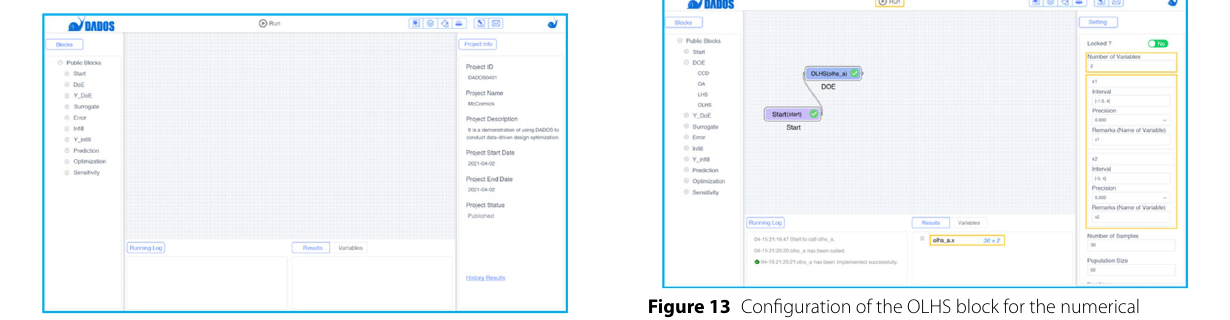
Figure 12 The blank main workspace screen of DADOS